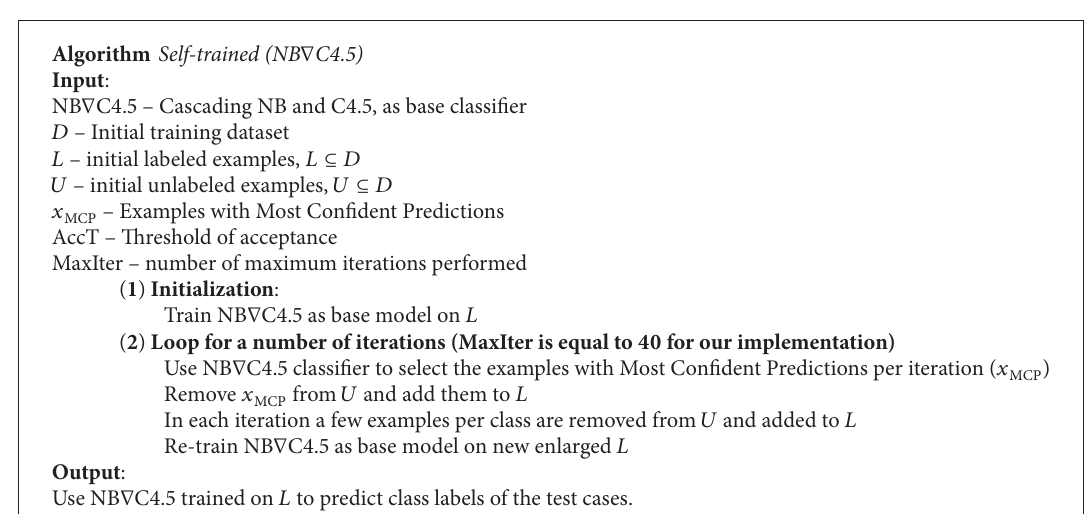
Algorithm 2: The self-trained (NB ∇ C4.5)